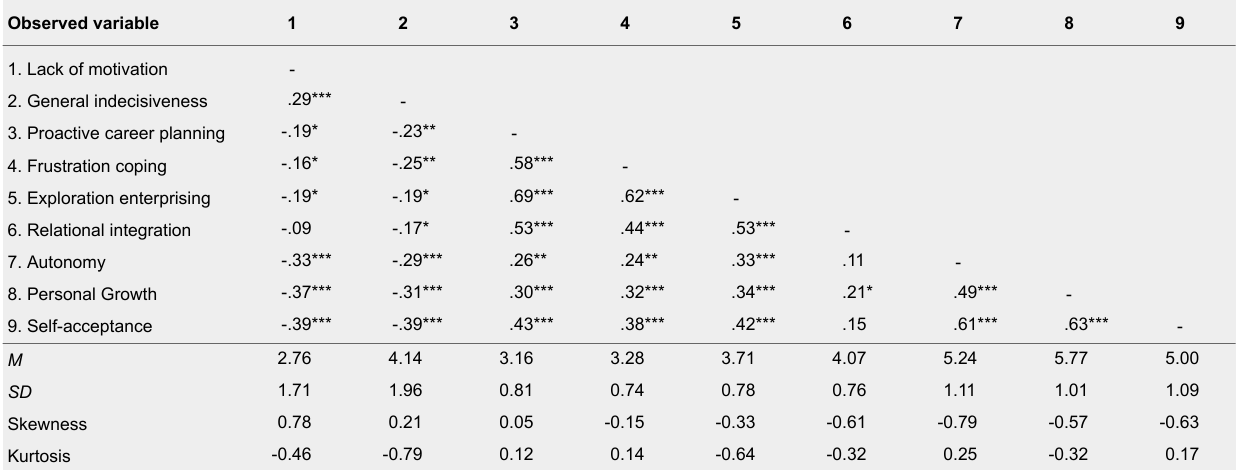
Correlations, Means, Standard Deviations, Skewness, and Kurtosis for the Key Study Variables Observed variable